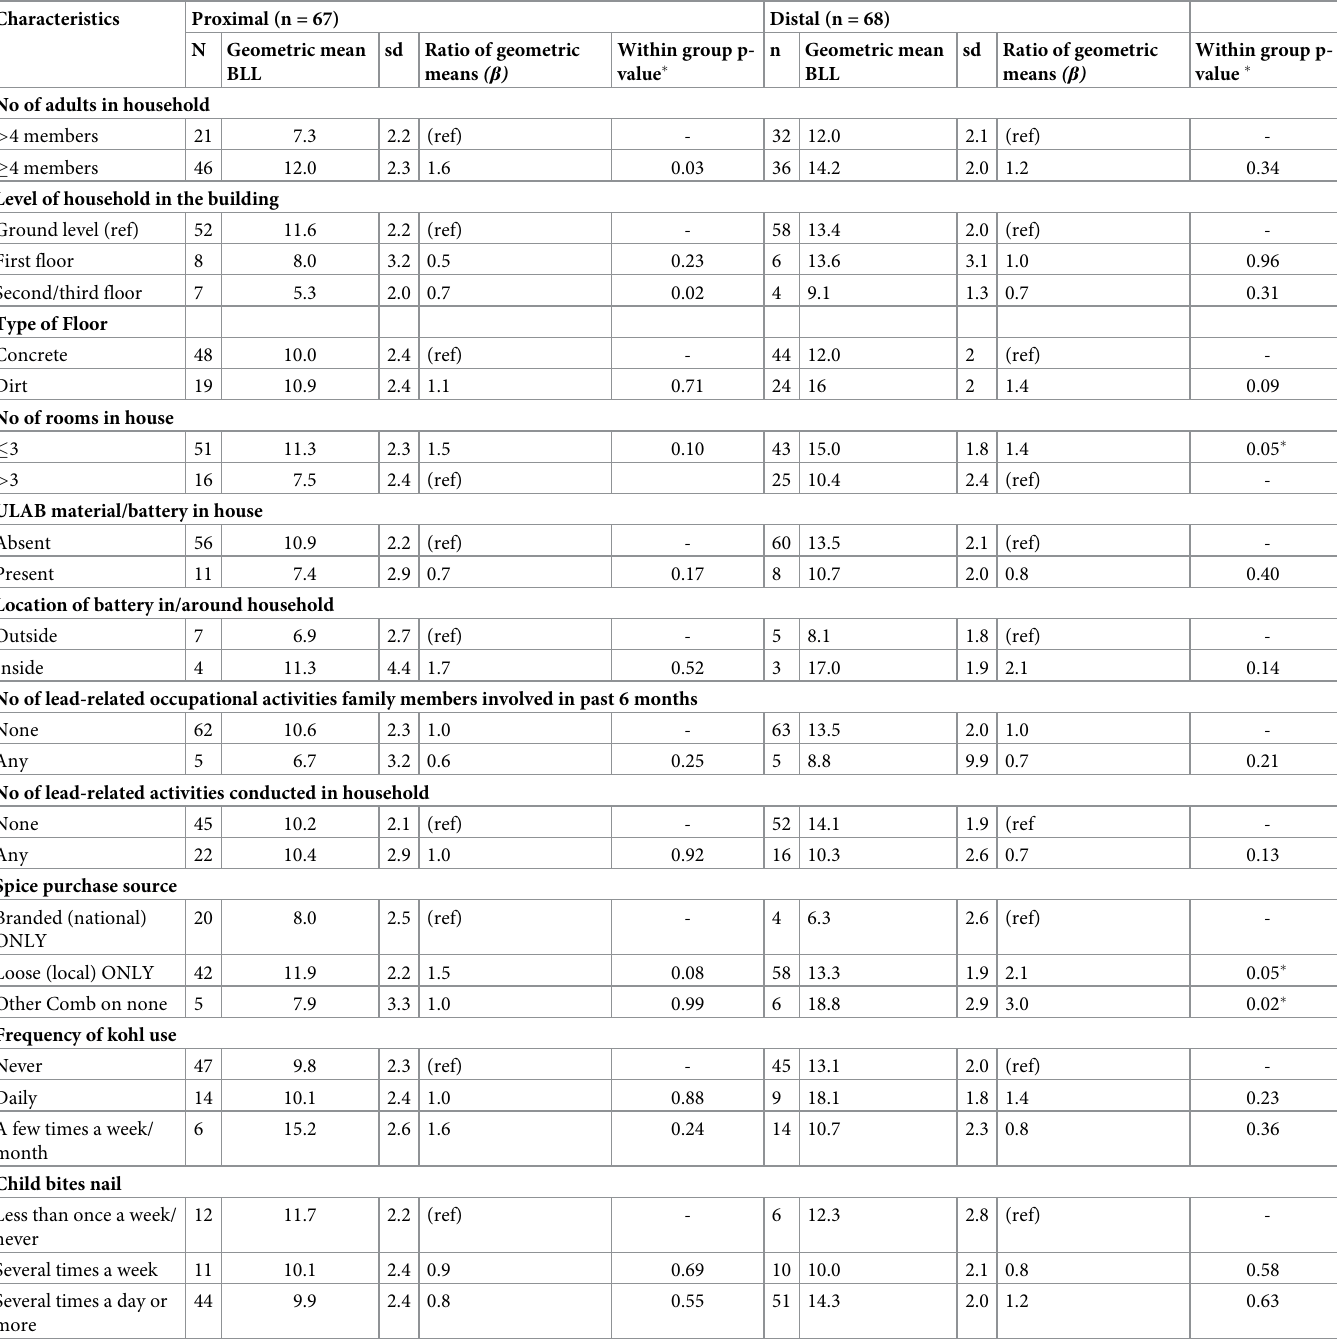
Table 5. Association between BLLs and various risk factors stratified by group (Proximal vs. Distal), Patna, Bihar, February 2020.